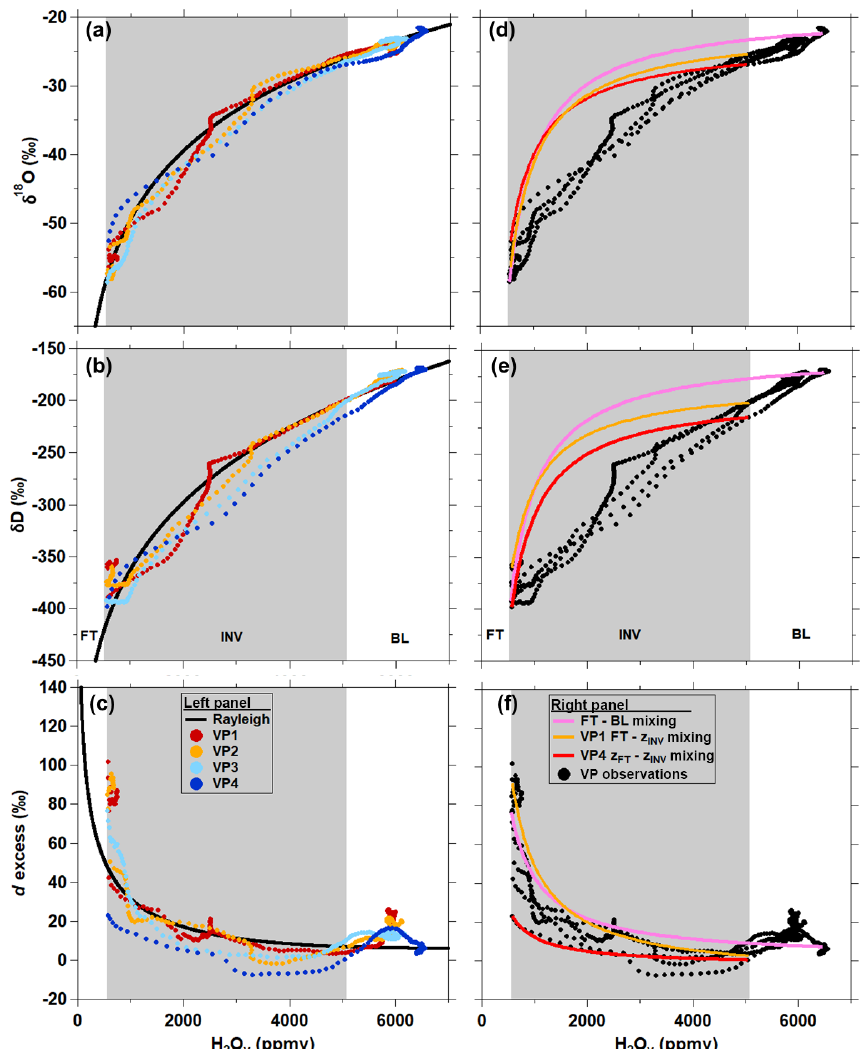
Figure 7. Comparison of vertical profile δ 18 O (a, d) , δ D (b, e) , and d -excess (c, f) measurements to Rayleigh theory (a, b, c) and mixing (d, e, f) curves for CLR (MAR06). Individual VP descents are indicated by the differently colored points. The bounds of the inversion layer (INV), indicated by grey shading, are defined by the average H 2 O v mole fractions observed at z INV and z FT